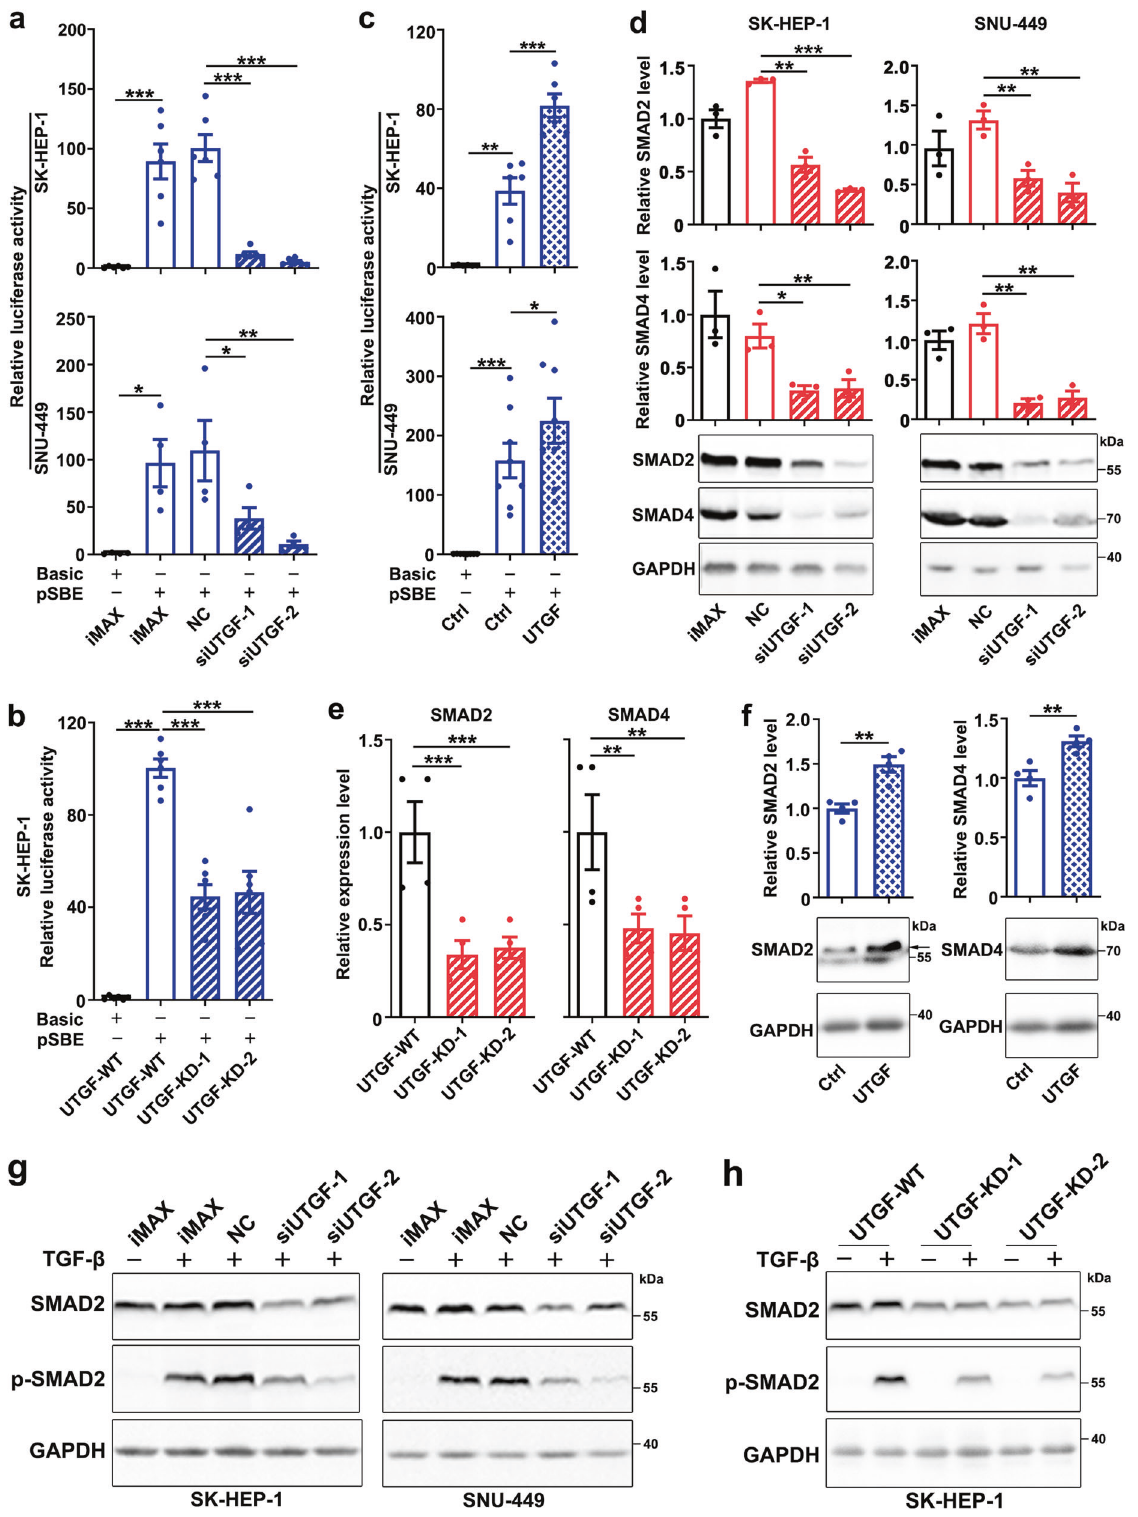
had a feedback control on the TGF- β /SMAD signaling. The transactivation activity of TGF- β signaling was fi rst measured by using pSBE, a luciferase reporter bearing SMAD-binding elements. As shown, TGF- β stimulated the pSBE activity and this effect was signi fi cantly attenuated in the cells transfected with